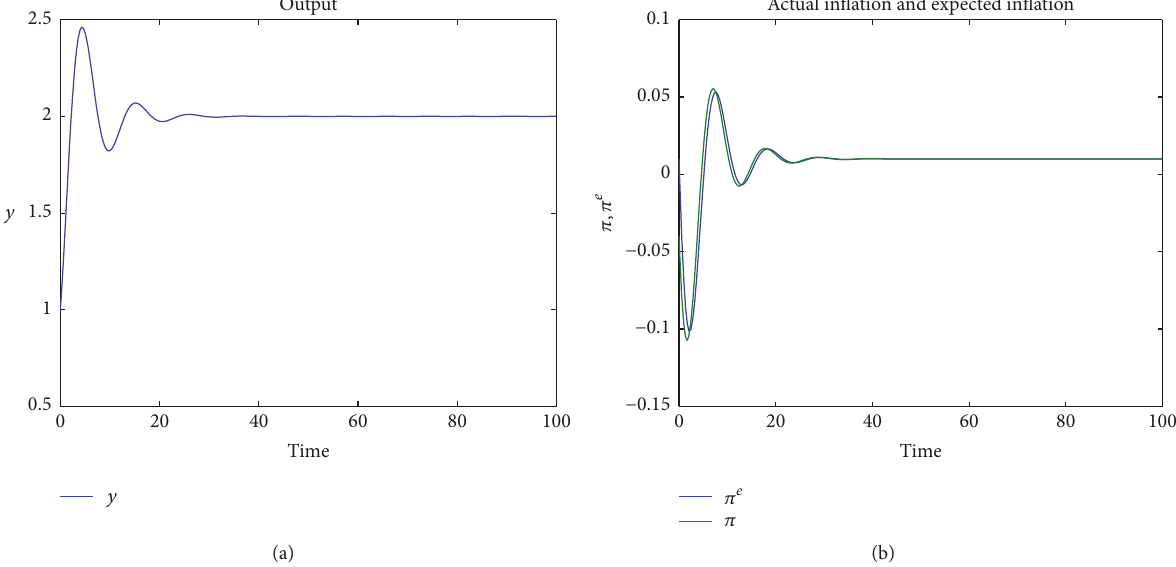
Figure 13: Supply side shock. (a) Solution for 𝑦(𝑡) . (b) Solutions for 𝜋(𝑡) and 𝜋 𝑒 (𝑡) .